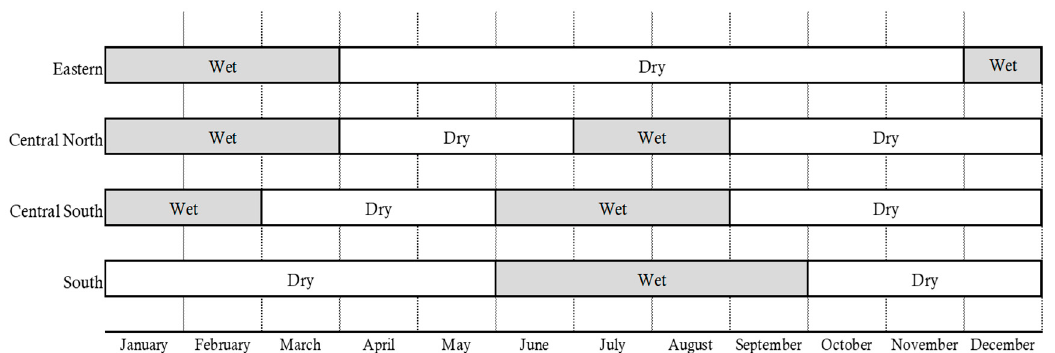
Figure 4. Weather seasons in Colombia per region. Source: Cenicafé, 2016. [47]. Note: eastern: Santander and eastern Cundinamarca; central north: Caldas, Antioquia, Risaralda, northern Tolima, and northern Cundinamarca; central south: Quind í o, Tolima, Valle Cauca, and northern Huila; south: